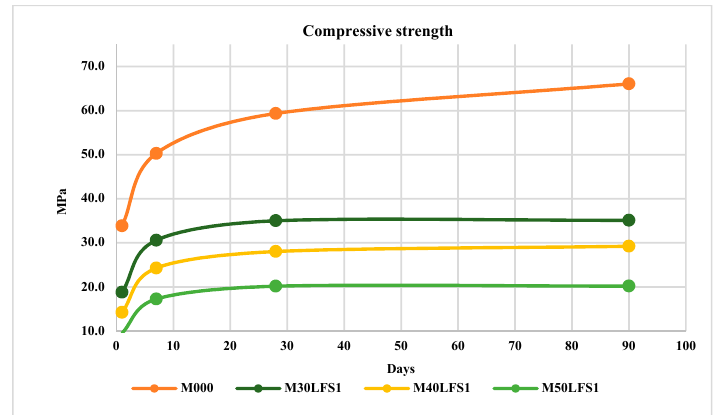
Figure 5. Compressive strength LFS1.